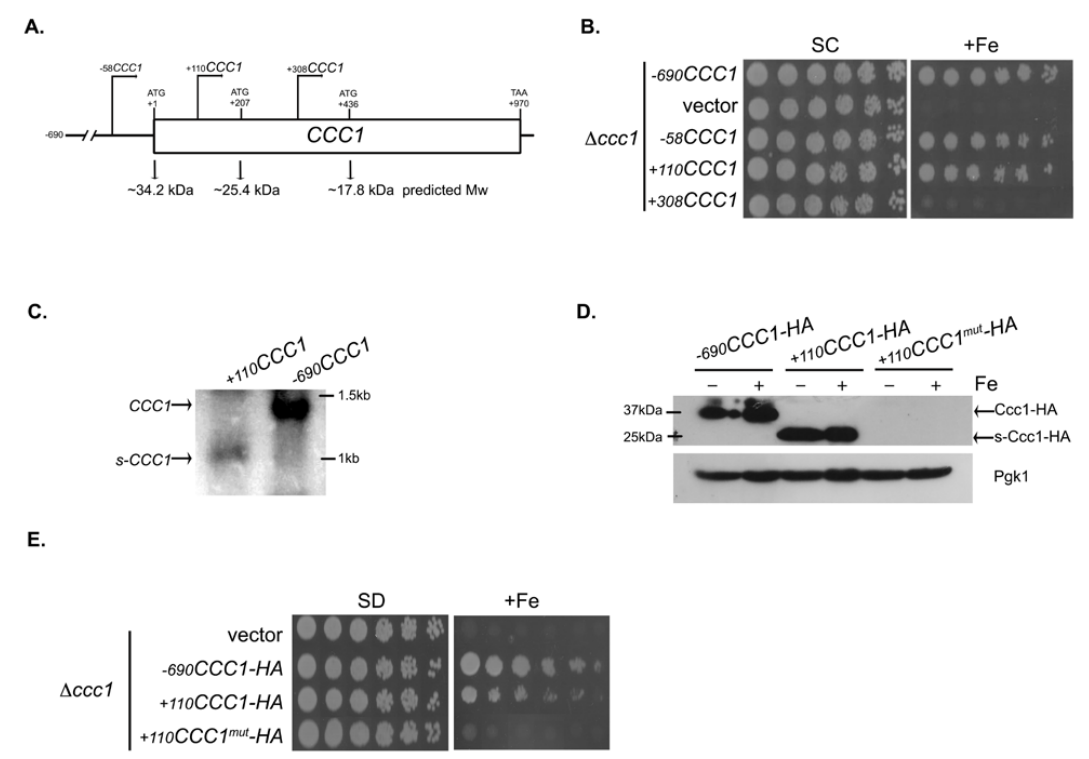
Figure 3. Deletions of CCC1, extending into the open reading frame, rescue the growth defect of the mutant Δ ccc1 due to the expression of an alternative, in frame, truncated version of the gene. ( A ) Schematic representation of the CCC1 gene. In frame ATGs and the molecular weight of the corresponding putative, in frame, truncated isoforms are showed. Angular arrows denote gene truncations carried by the indicated constructs. ( B ) Exponentially growing Δ ccc1 cells transformed with the indicated plasmids or with pRS416 (vector), were serially diluted, spotted onto SD plates supplemented or not with 10 mM of FeSO 4 and grown for 2 days at 30 °C. ( C ) Exponentially growing Δ ccc1 cells expressing s-CCC1 (+110CCC1 ) or CCC1 ( − 690CCC1 ) were harvested and total RNA was analyzed by Northern blotting with a CCC1 ribo-probe. ( D ) Protein extracts from Δ ccc1 cultures carrying the plasmids expressing the indicated HA tagged CCC1 versions and left untreated ( − ) or treated (+) with FeSO 4 for 30 min, were analyzed by immunoblotting using an anti-HA antibody. Pgk1 levels served as loading control. Mutation of the triplet ATG located at position +207 (+ 110CCC1 mut -HA) eliminates expression of the truncated isoform and ( E ) renders Δ ccc1 unable to grow in medium supplemented with 7 mM of FeSO 4 (+Fe).